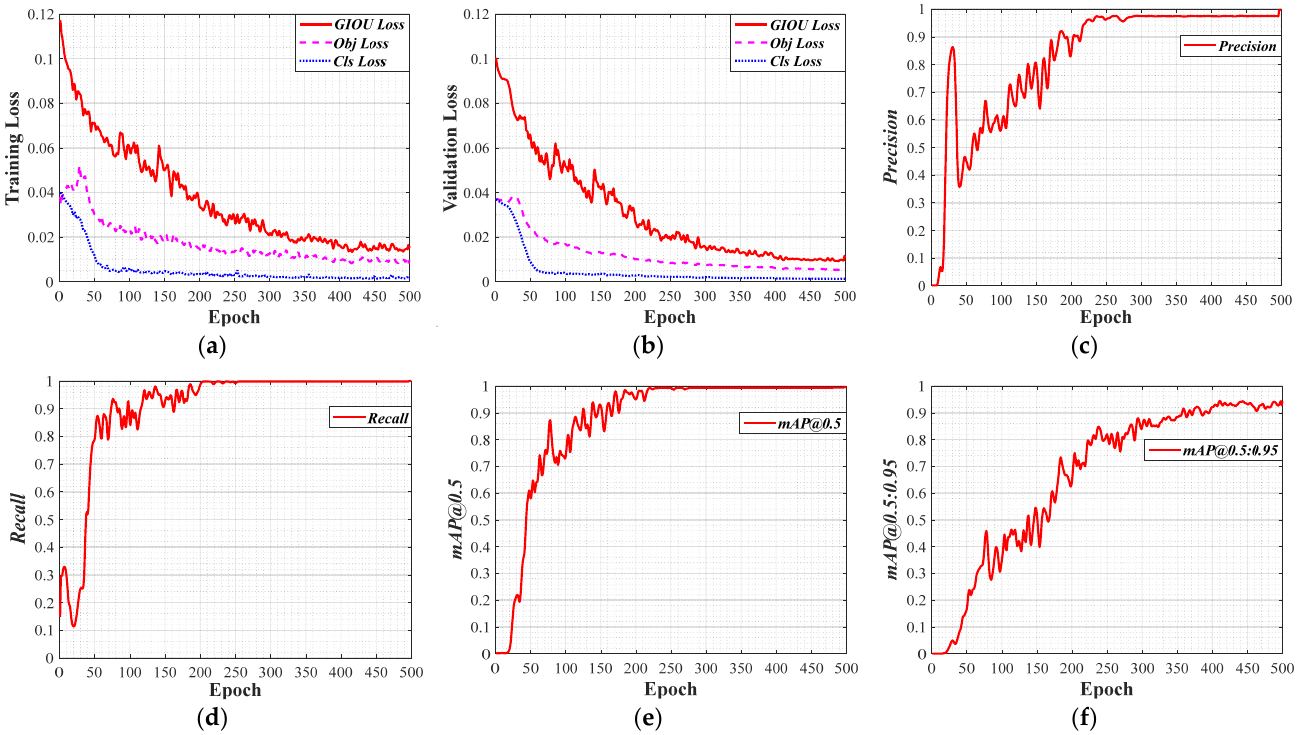
Figure 6. Training results of the model: ( a ) training loss; ( b ) validation loss; ( c ) precision; ( d ) recall; ( e ) mAP@0.5; ( f ) mAP@0.5:0.95.